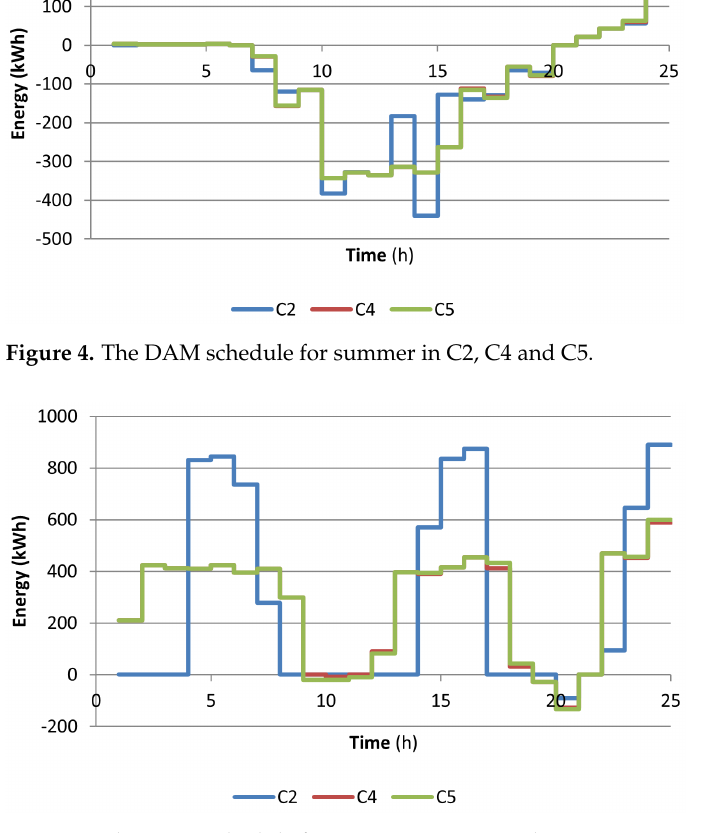
Figure 5. The DAM schedule for winter in C2, C4 and